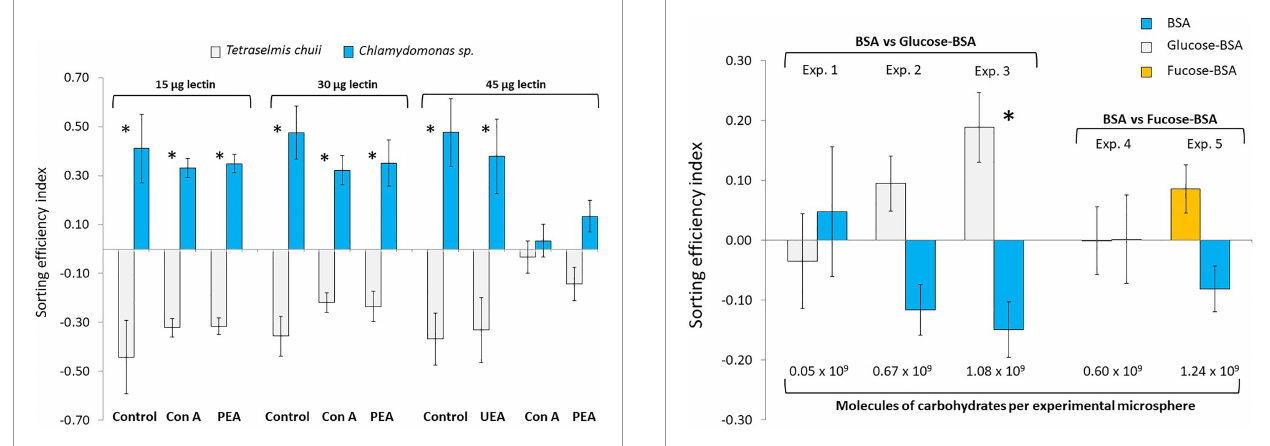
FIGURE 2 | Sorting ef fi ciencies (mean ± standard deviation, n = 12 per data point) of M. edulis fed a mixture of Tetraselmis chuii and Chlamydomonas sp. treated with FITC-lectins (Con A, PEA and UEA; 15, 30 and 45 µg lectin per 10 6 cells per ml) or seawater (control). *Indicates signi fi cant sorting.